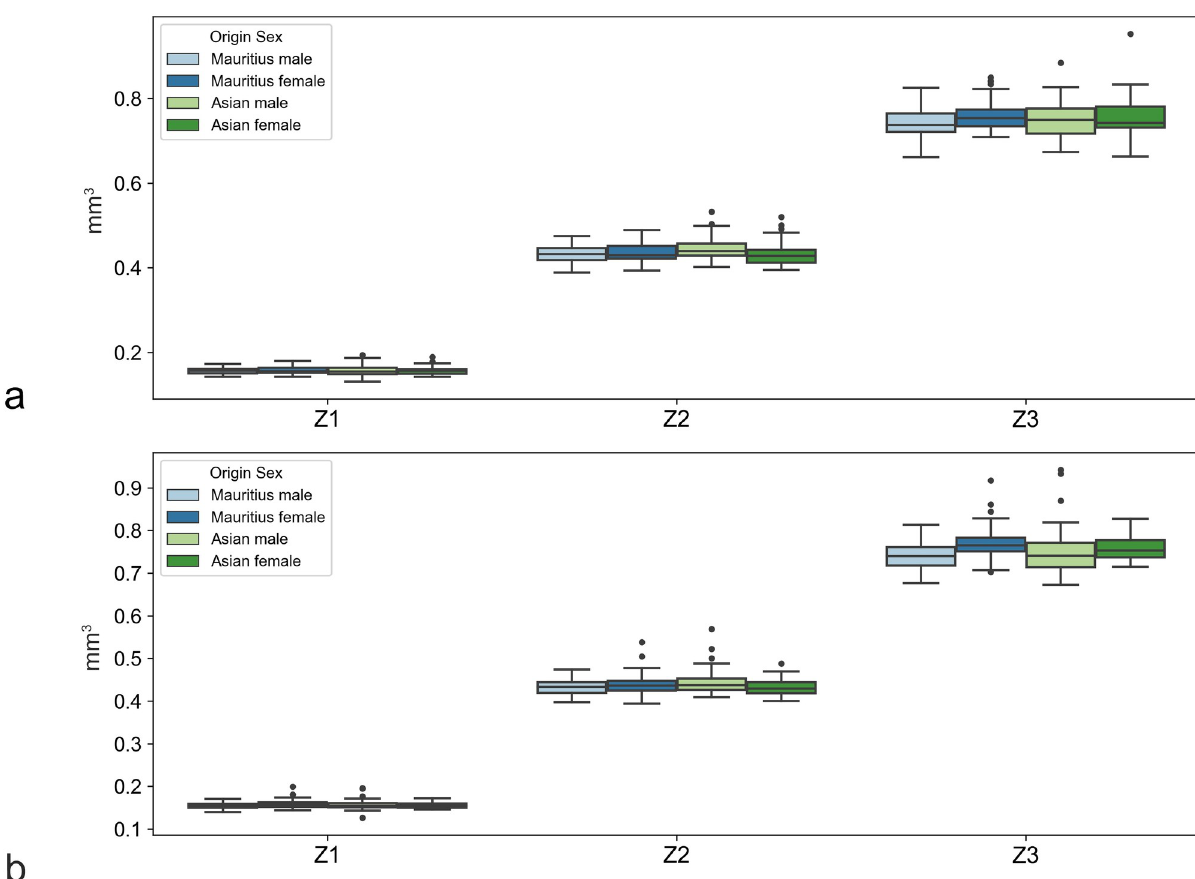
Fig 2. Boxplots of sex-specific variations in choroid volumes. For right ( 2a , OD) and left eyes ( 2b , OS) measured as circular zones centered on the foveolar depression.